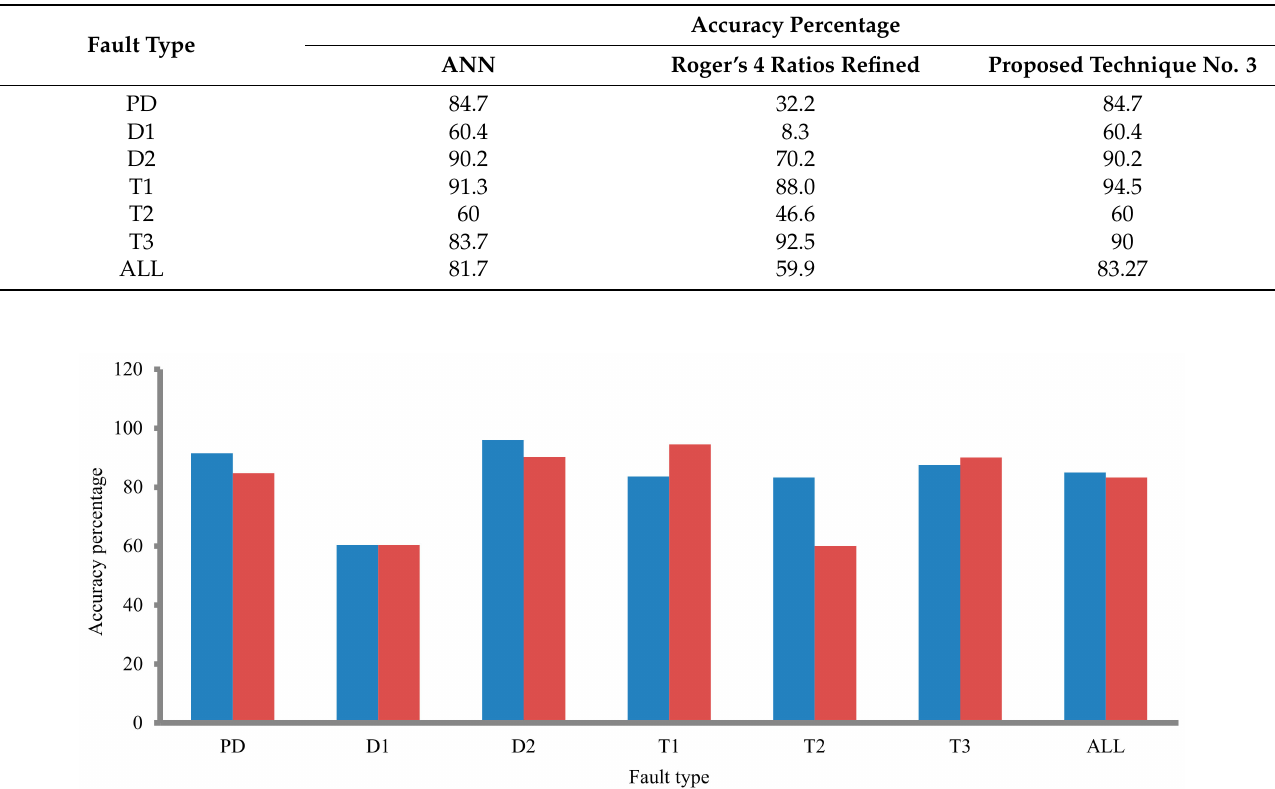
Table 4. Accuracy percentages of no. 3, ANN, and Roger’s 4 ratios refined techniques.